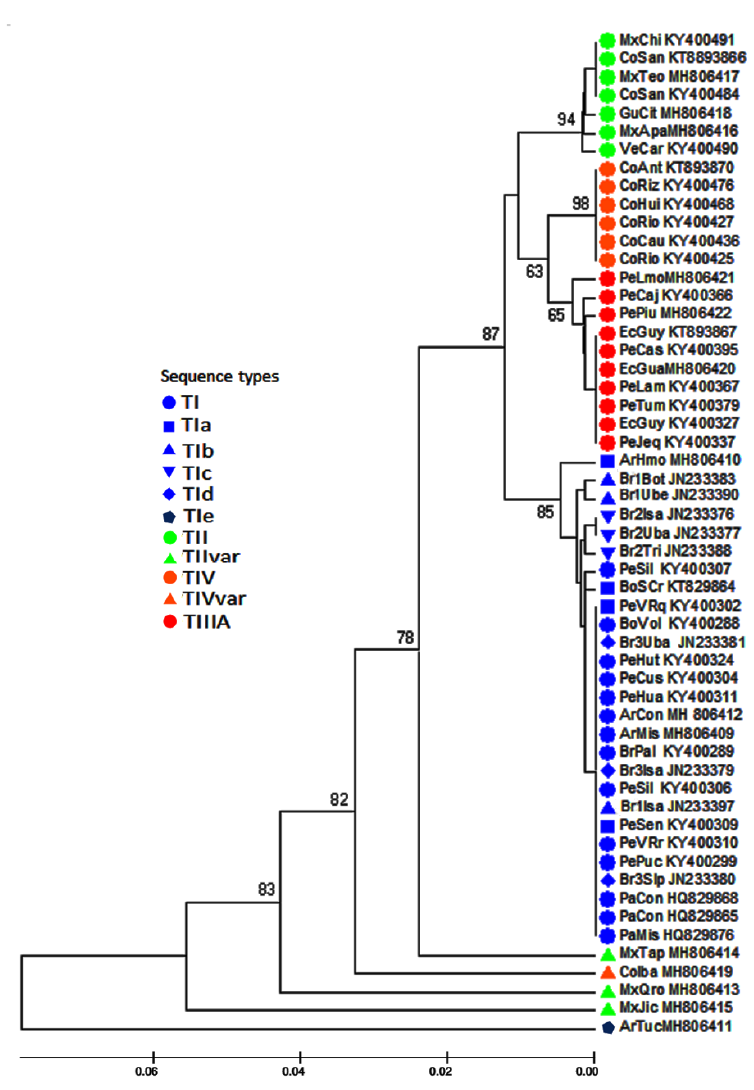
Figure 4. Overall similarity of the ITS1 sequences of the AF complex. The similarity of the sequences was inferred using the UPGMA (unweighted pair-group method with arithmetic means) method. The percentage of replicate trees in which the associated taxa clustered together in the bootstrap test (1000 replicates) are shown next to the branches. The evolutionary distances were computed using the maximum composite likelihood method and are in units of the number of base substitutions per site. The rate variation among sites was modeled with a gamma distribution (shape parameter = 1). All positions containing gaps and missing data were eliminated.